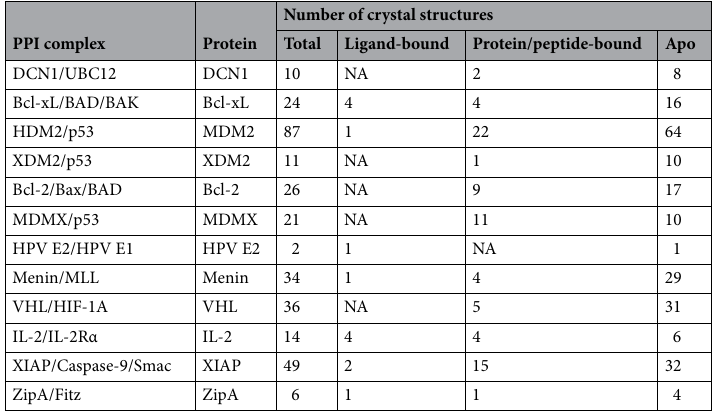
Table 1. The final PPI dataset containing 320 hand-curated protein crystal structures belonging to 12 PPI targets. NA Not available.